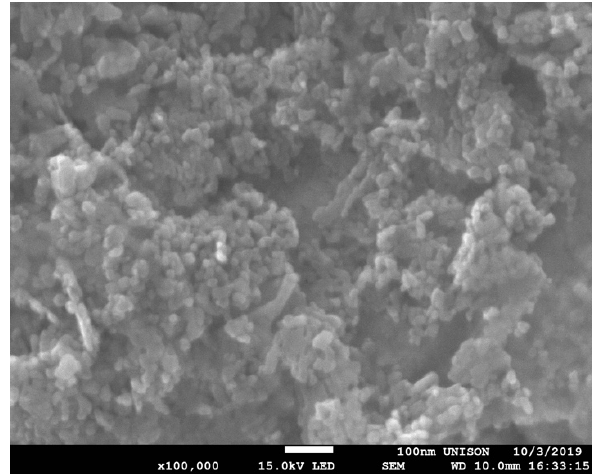
Figure 1. STEM imagen of ZnONPs shows a spherical shape. The scale bar represent a 100 nm length.